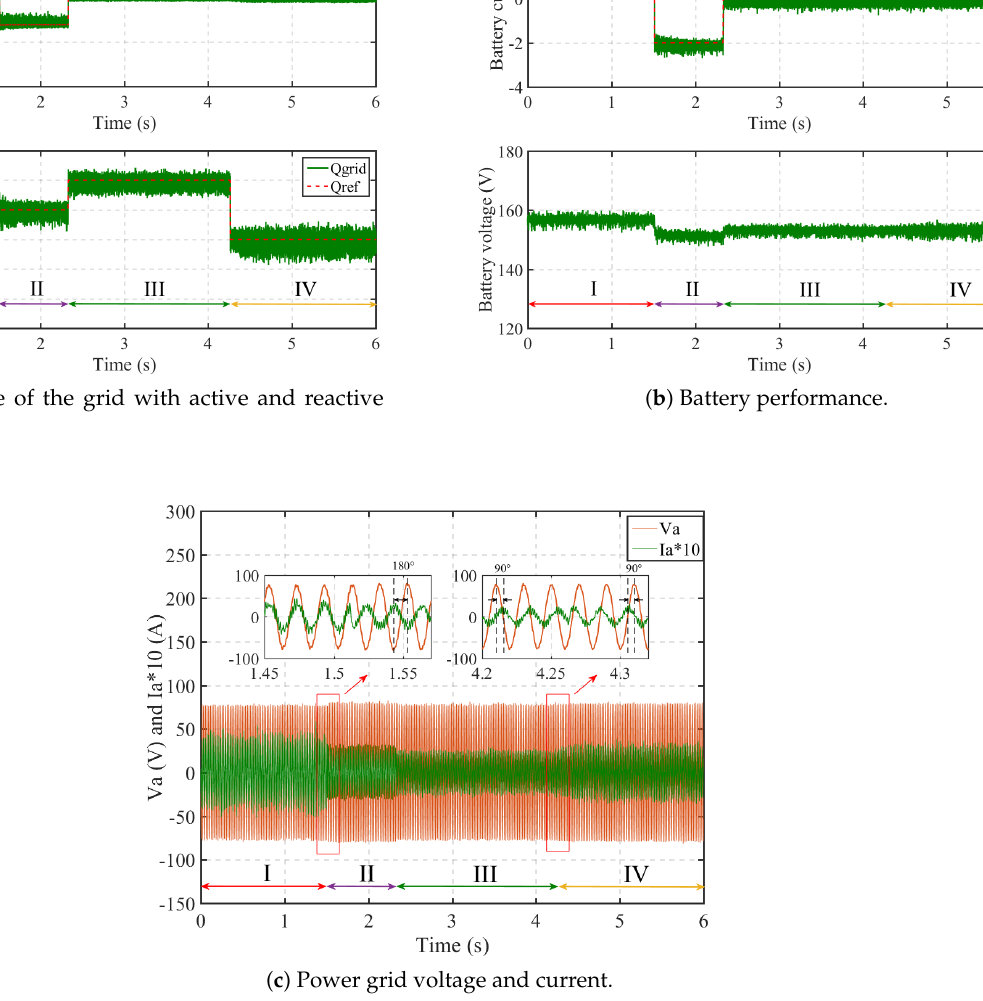
Figure 11. Experimental results in Quadrants I, II, III, and